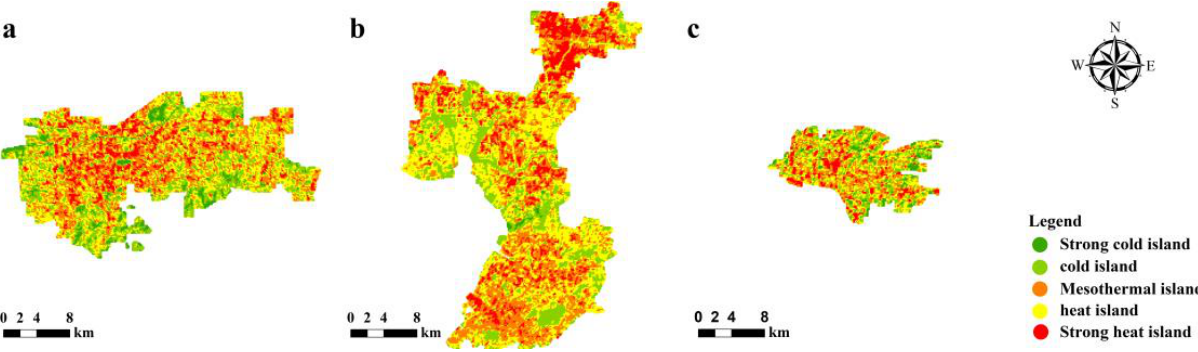
Figure 4. Distribution of heat island intensity in ( a ) Jinan, ( b ) Qingdao, and ( c ) Heze.